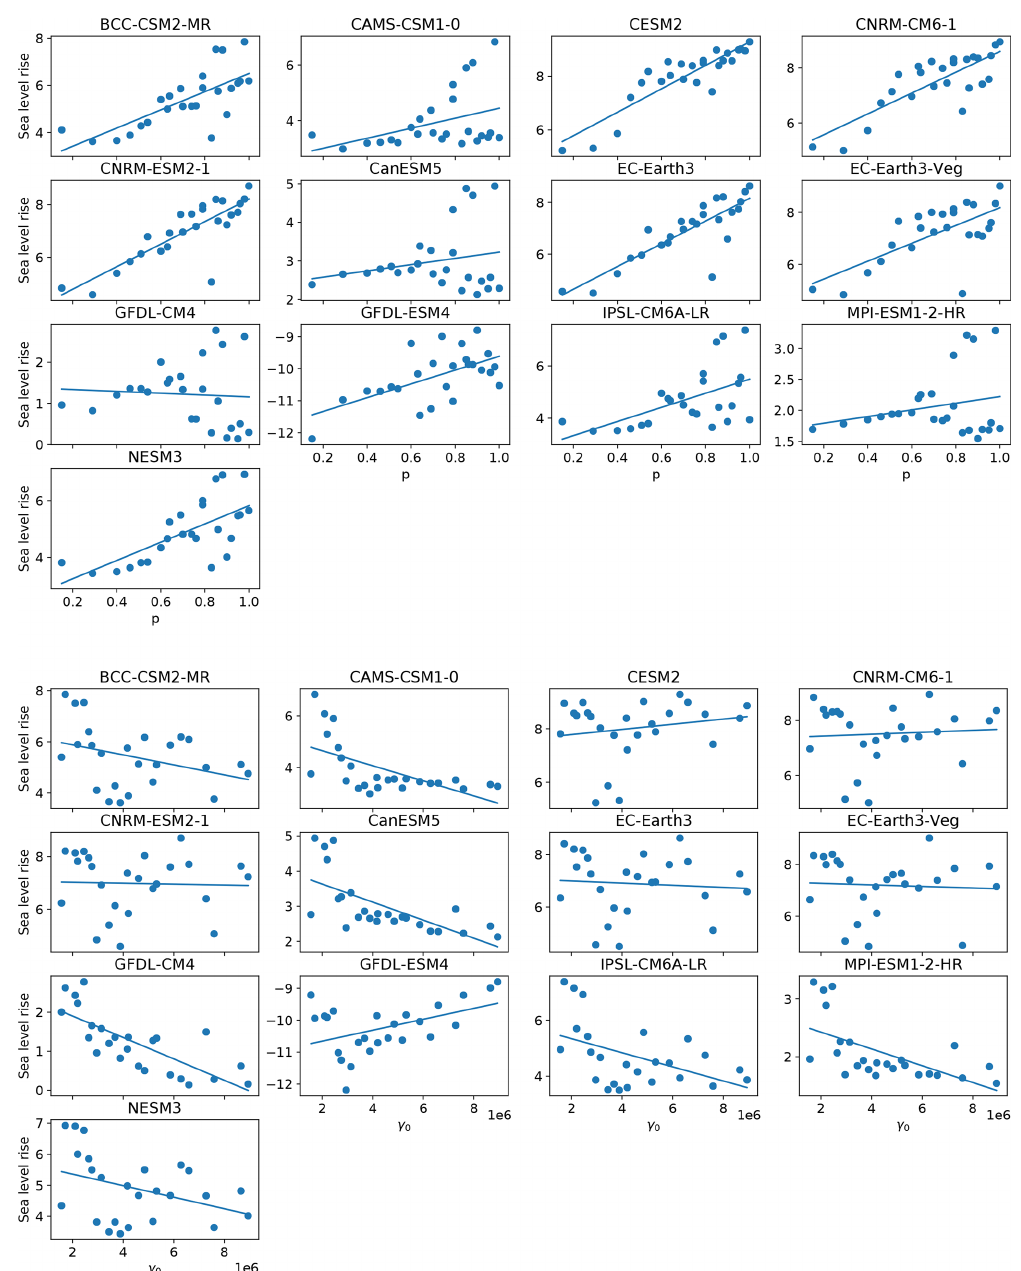
Figure A7. SLR as a function of p and γ 0 in the Antarctic Peninsula (AP) region.